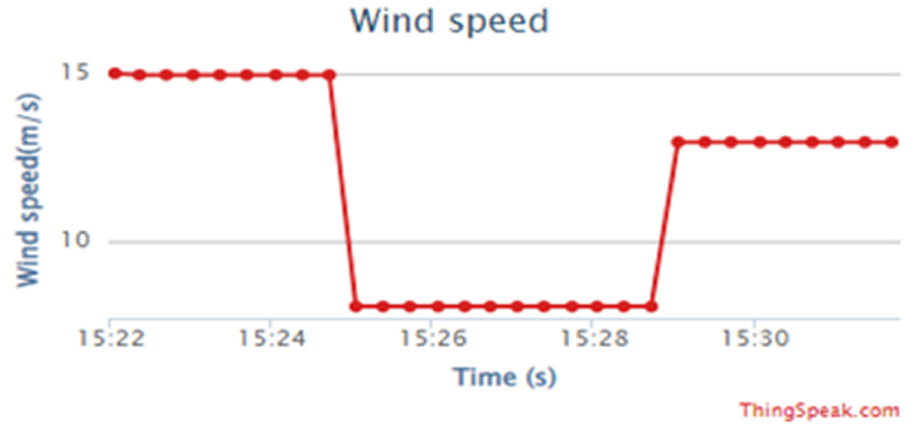
Figure 11. Proposed wind speed